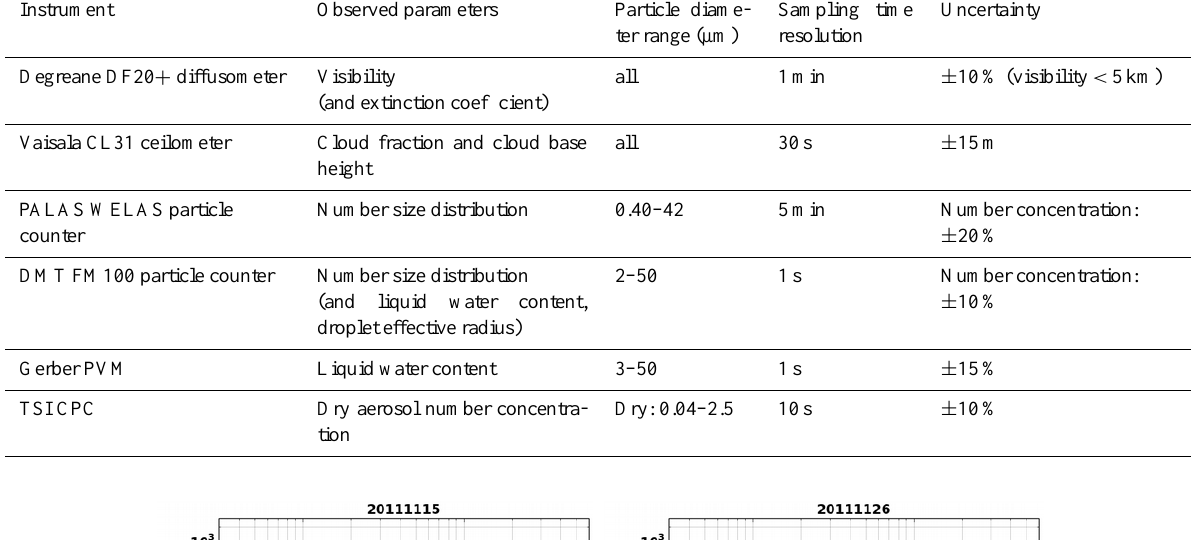
Table 1. Instrumental set-up at SIRTA for the measurement of particle properties in ambient and dry (only CPC) conditions.